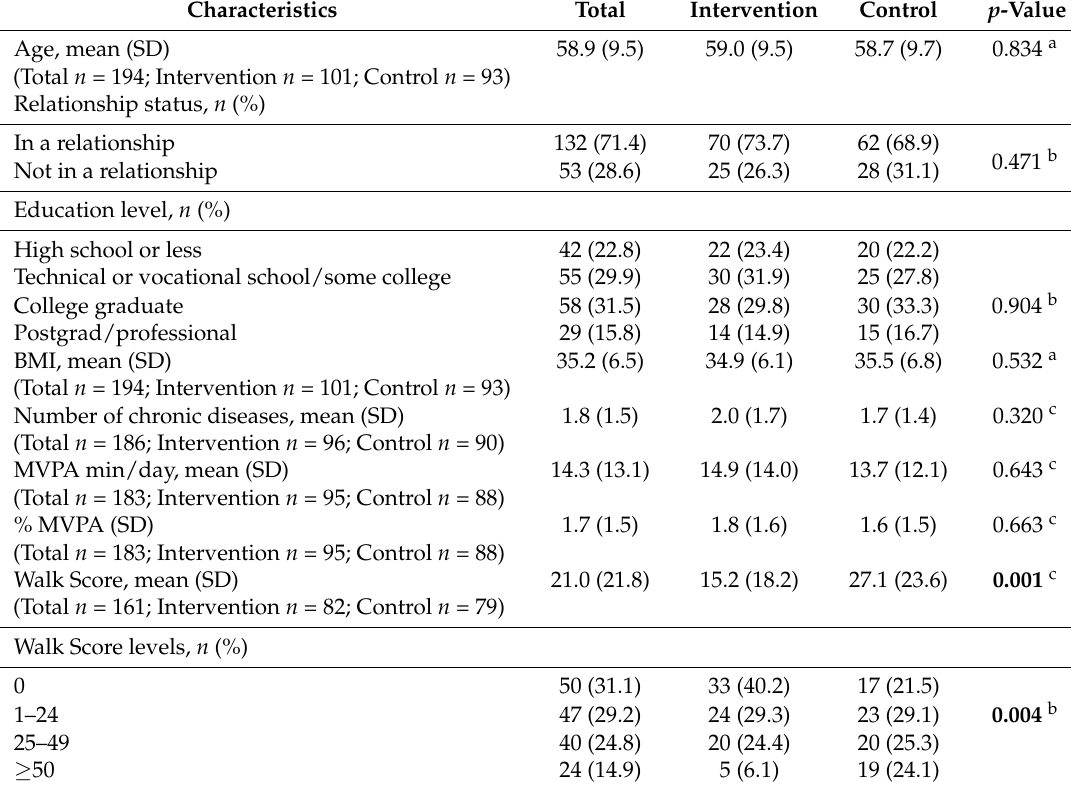
Table 1. Baseline characteristics of participants, Walk Score, and perceived built environment characteristics.